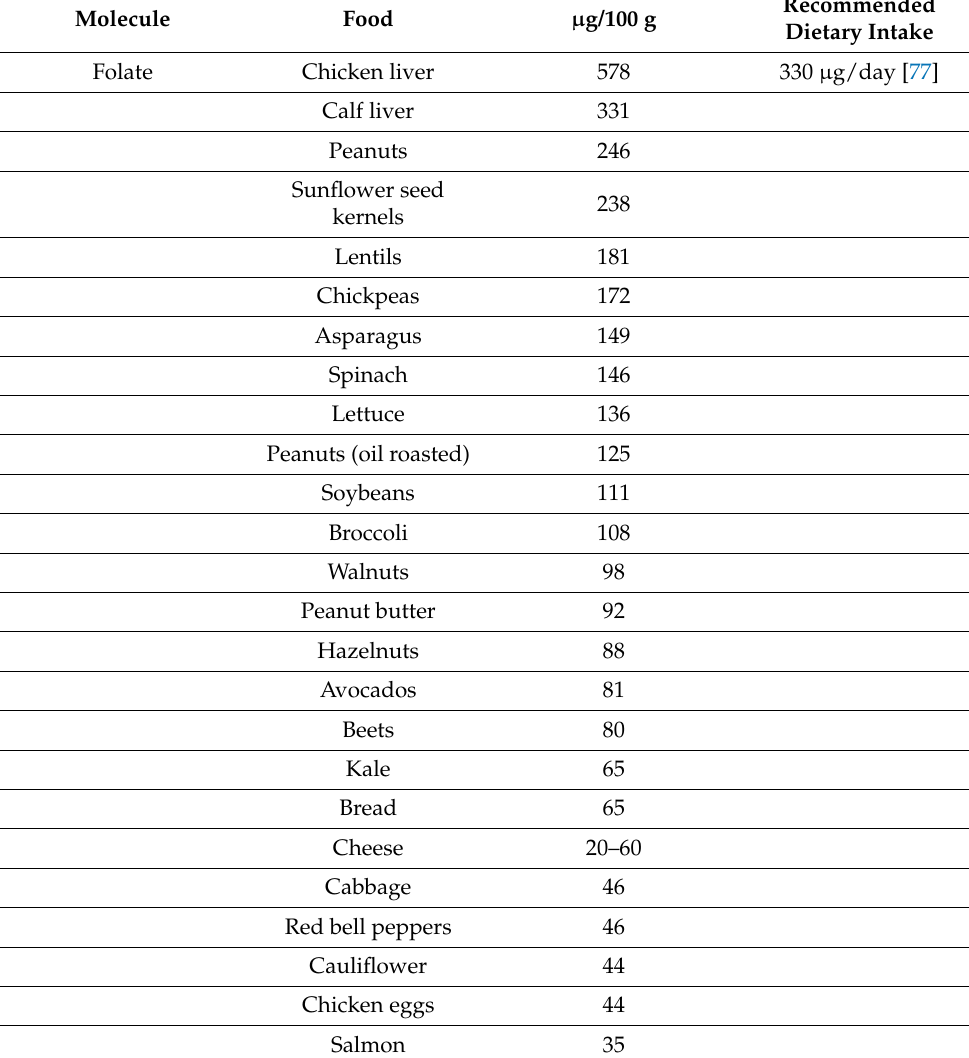
Table 1. Food containing nutrients affecting